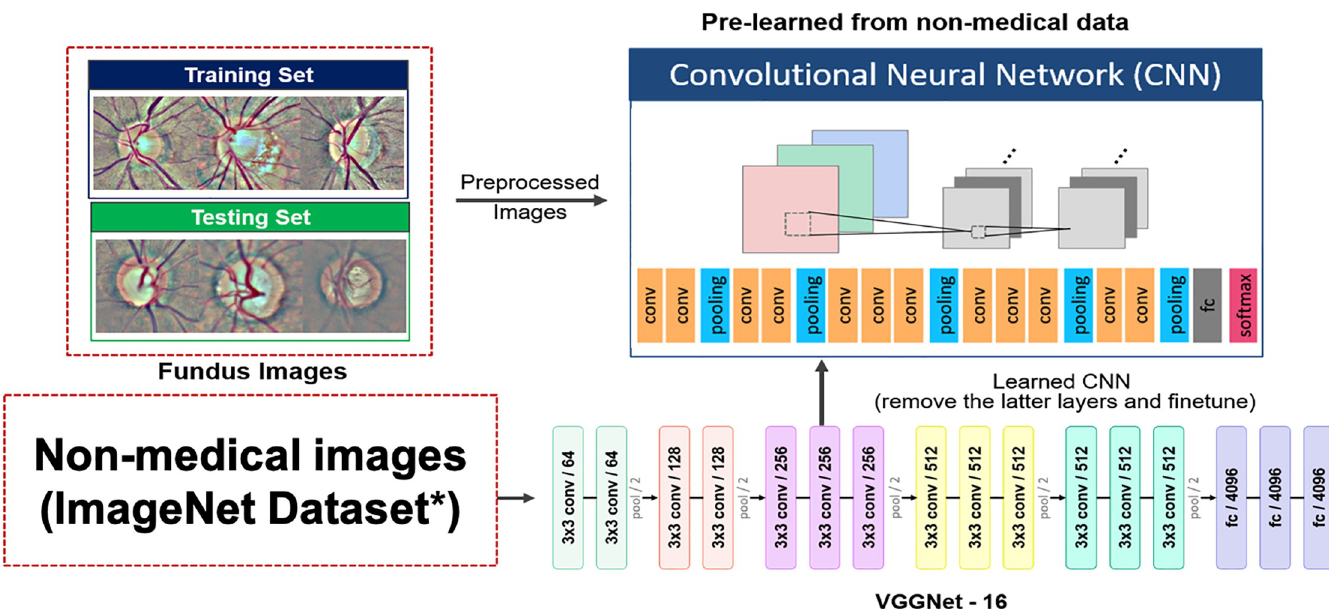
Fig 3. Transfer learning and VGGNet architecture. Under transfer learning strategy, the CNN model was initialized with the trained weight of VGGNet with a 3 x 3-sized filter. The final model contained convolutional layers, pooling layers, and the fc layer. VGGNet, invented by Visual Geometry Group from University of Oxford; CNN, convolutional neural network; conv, convolutional; fc, fully connected. � Russakovsky O, et al. ImageNet large scale visual recognition challenge. IJCV . 115, 211– 252